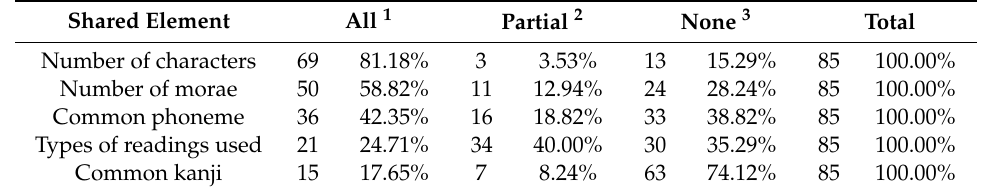
Table 6. Number of paired names with commonalities between siblings (overview)